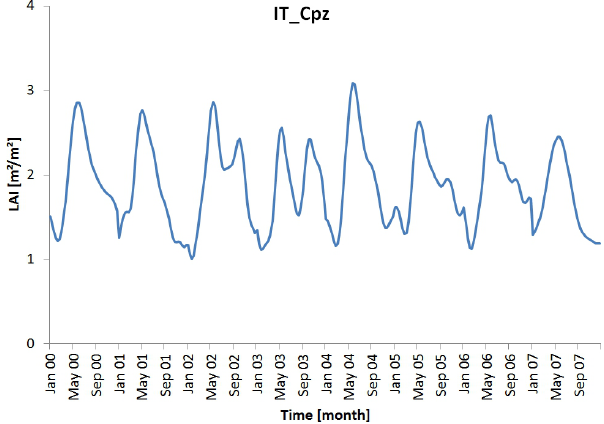
Figure 4: Leaf Area Index time series as derived from CYCLOPES for the IT_Cpz 2 Fig. 4. Leaf area index time series as derived from CYCLOPES for FLUXNET site. Data is given as 10-day composites for the period 2000 - 2007. 3 the IT_Cpz FLUXNET site. Data is given as 10 day composites for the period